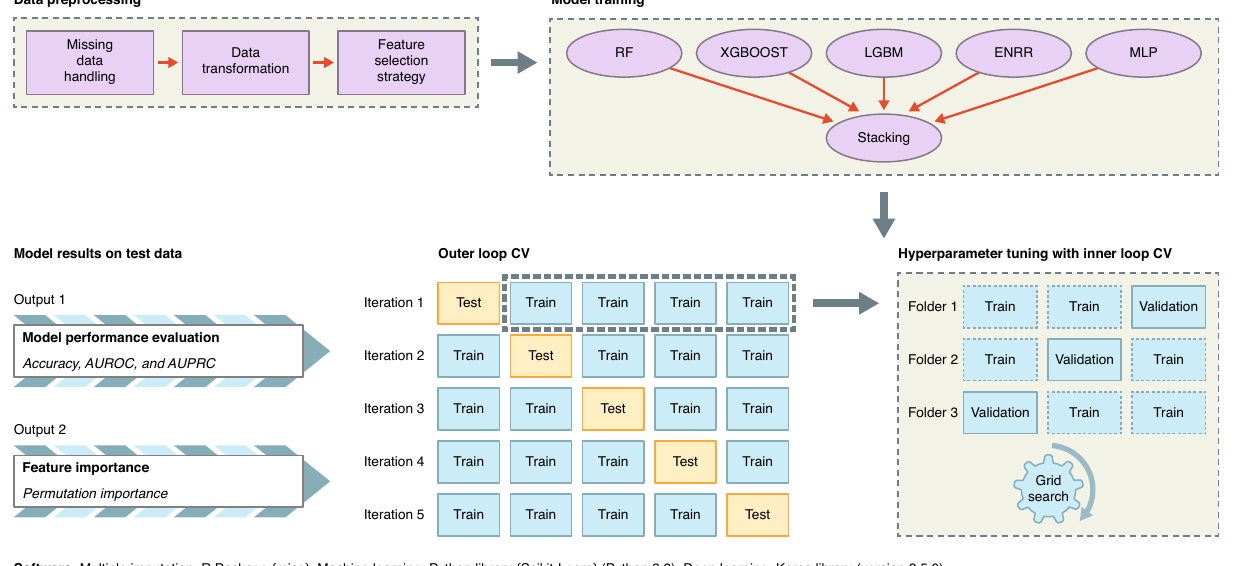
Figure 3. The workflow of stacking ensemble